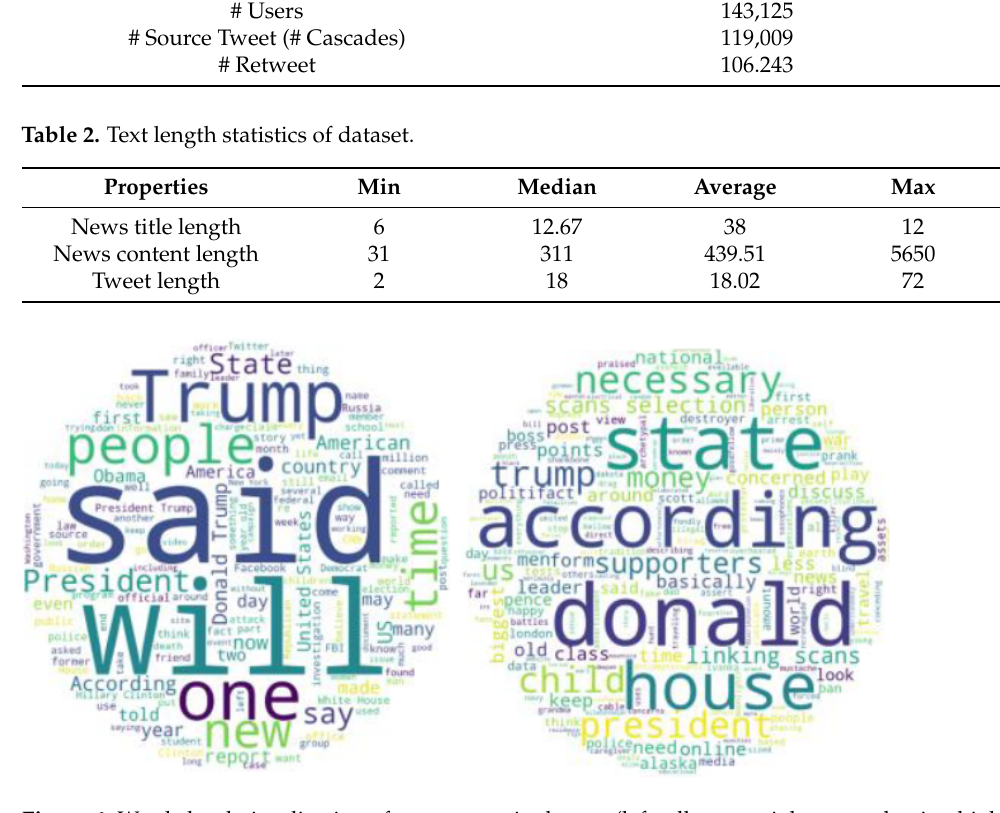
Figure 6. Word cloud visualization of news terms in dataset (left: all terms, right: terms having high TF-IDF value).